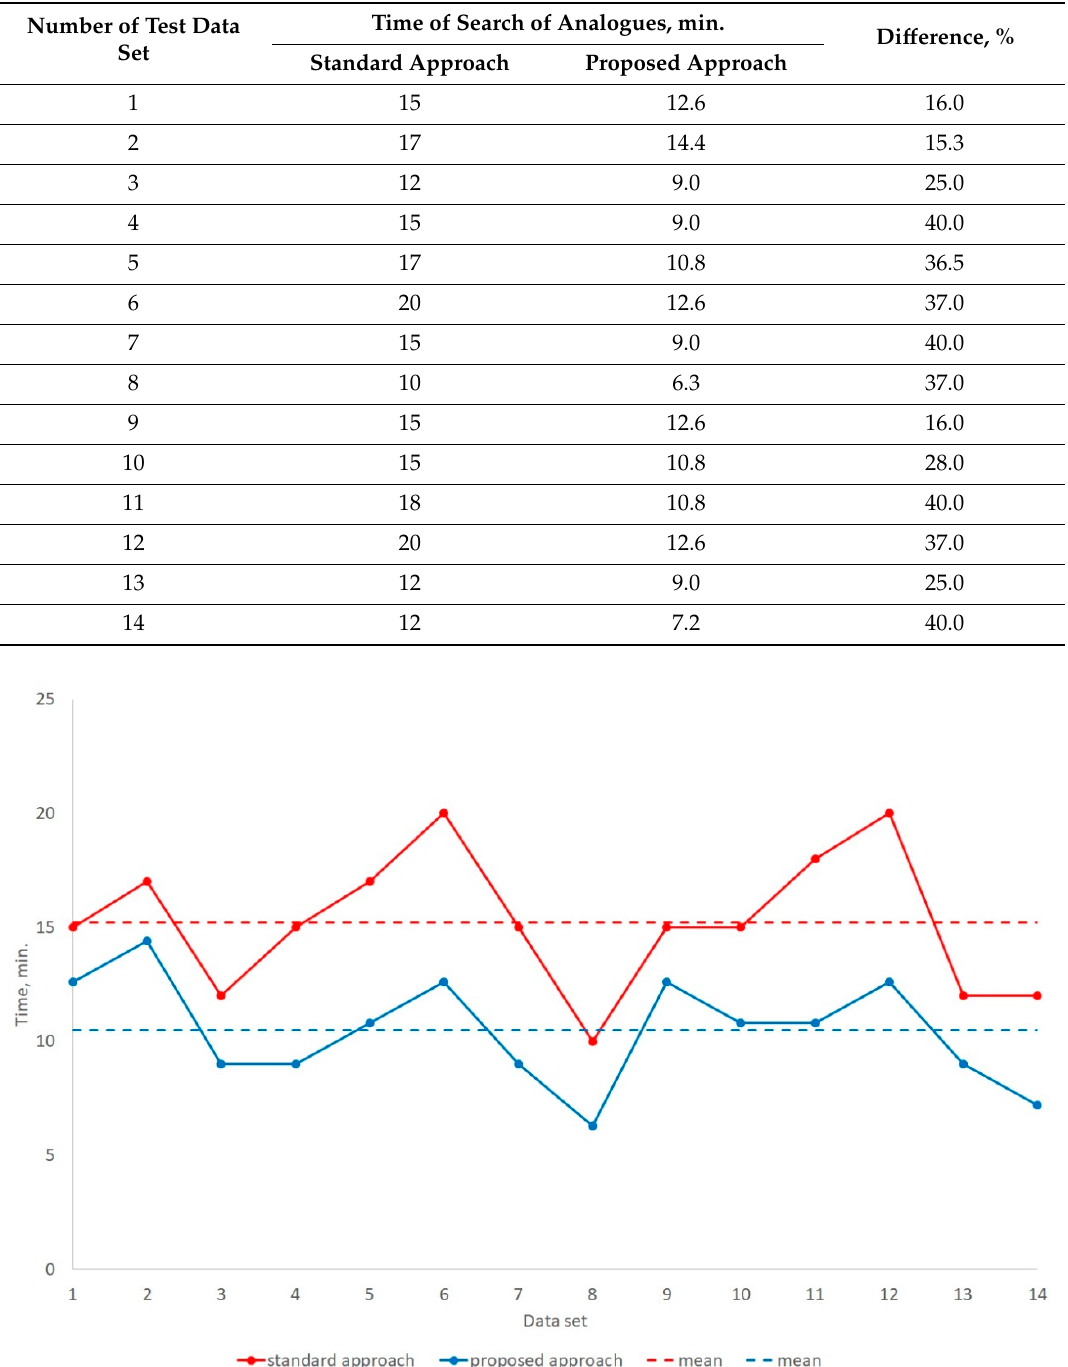
Table 2. Measurement results of search of analogues runtime by experts.